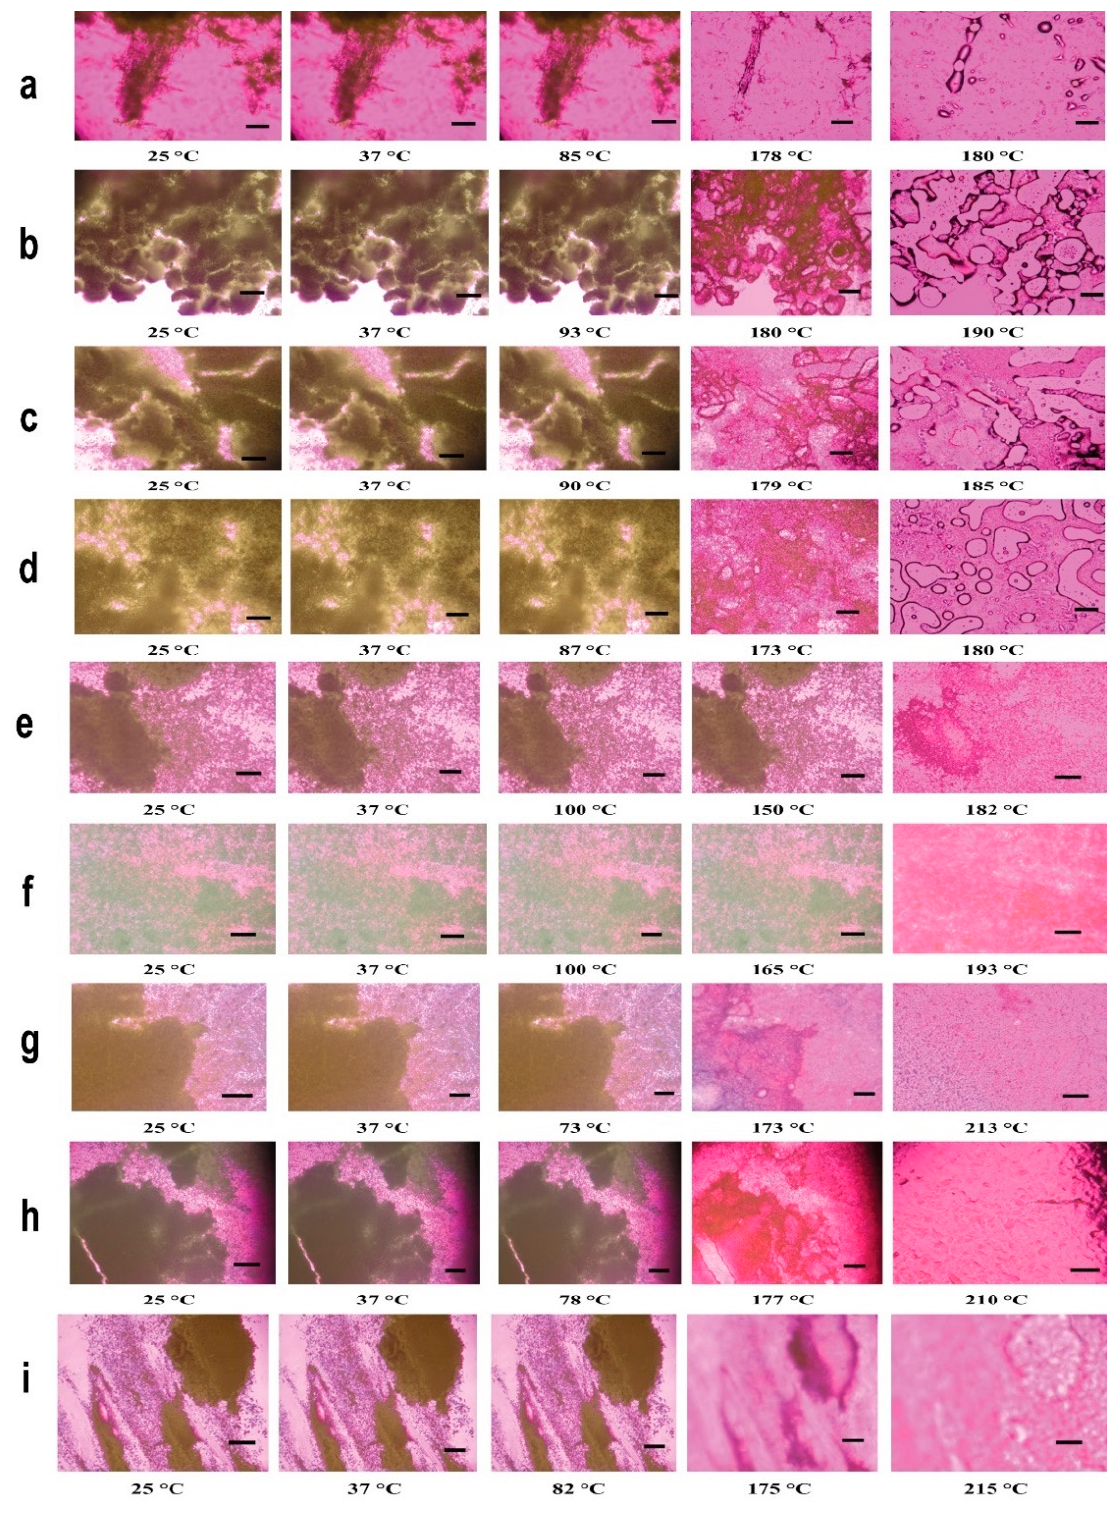
Figure 5. Representative HSM images for: ( a ). Raw Lactomorphin; ( b ). SD-Lactomorphin in methanol at 25% PR; ( c ). SD-Lactomorphin in methanol at 50% PR; ( d ). SD-Lactomorphin in methanol at 75%PR; ( e ). SD-Lactomorphin in ethanol at 25% PR; ( f ). SD-Lactomorphin in Isopropanol at 25% PR; ( g ). Co-SD-Lactomorphin:Trehalose 25:75 in methanol at 25% PR; ( h ). Co-SD-Lactomorphin:Trehalose 50:50 in methanol at 25% PR; ( i ). Co-SD-Lactomorphin:Trehalose 75:25 in methanol at 25% PR. Scale bar: 10 μ m.